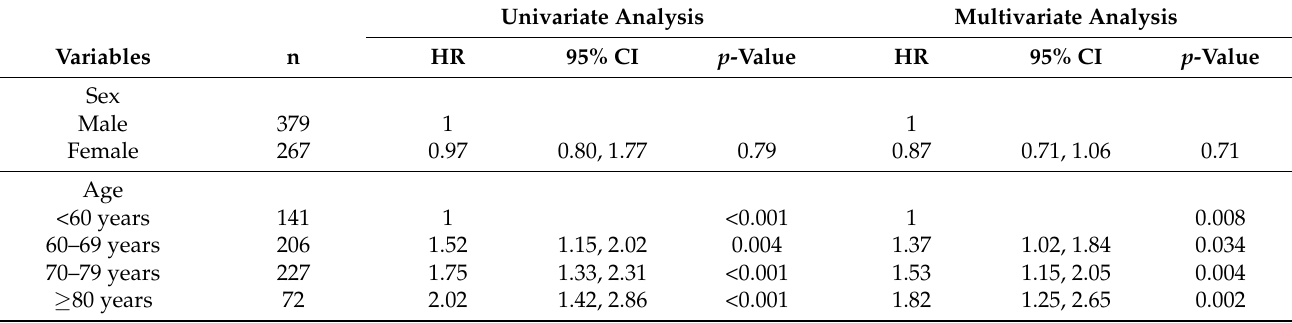
Table 3. Multivariate survival analysis of pancreatic cancer patients at 5 years of follow-up. Univariate Analysis Multivariate